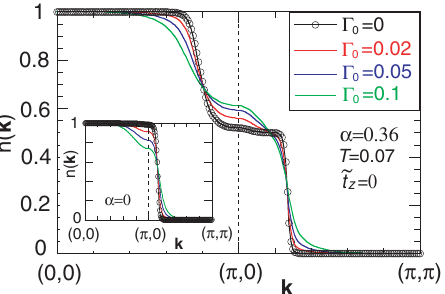
Fig. 5 Momentum distribution function n (k) calculated in the presence of damping of quasiparticles in the nematic scenario presented in Fig. 3. The damping depends on momentum, becomes the largest at ( π , 0), and its magnitude is controlled by Γ 0 ; see Supplementary Note 7 for details. The inset is the corresponding result for the conventional hole-like Fermi surface believed so far for La-based